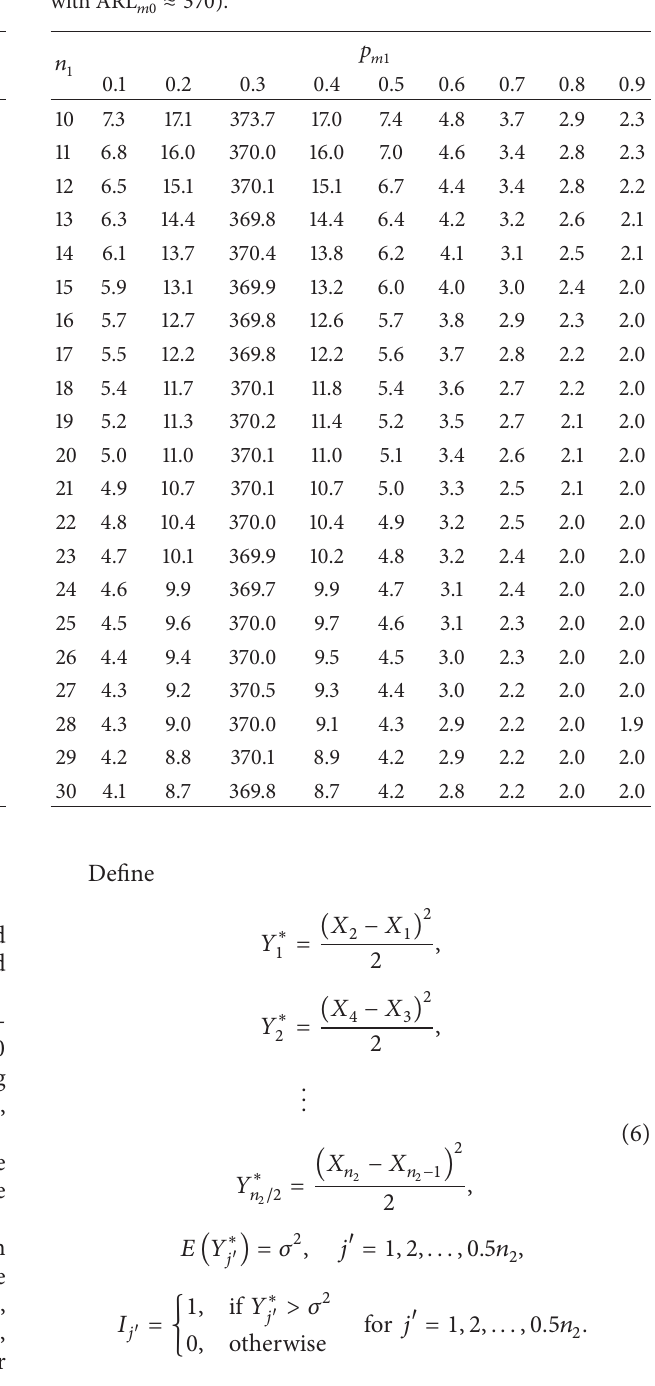
Table 3: The ARL 𝑚1 of the EWMA-AM chart ( 𝜆 1 = 0.05 , 𝑝 𝑚0 = 0.3 with ARL 𝑚0 ≈ 370